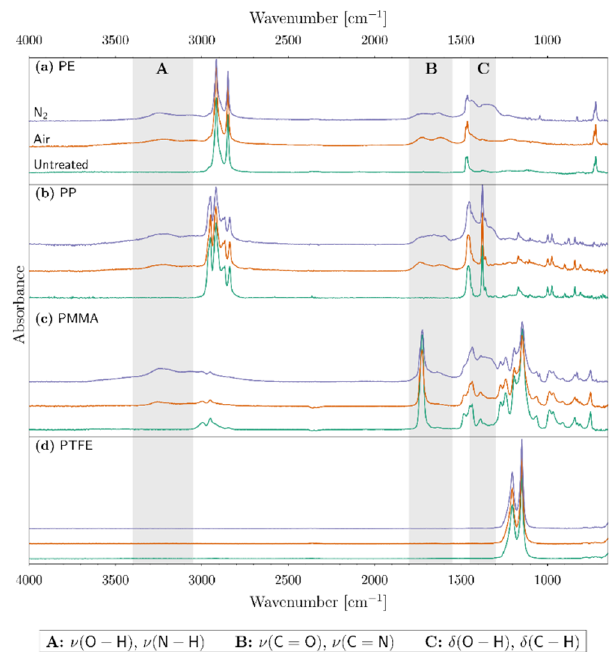
Figure 6. Infrared spectra of treated and untreated ( a ) PE, ( b ) polypropylene (PP), ( c ) PMMA, and